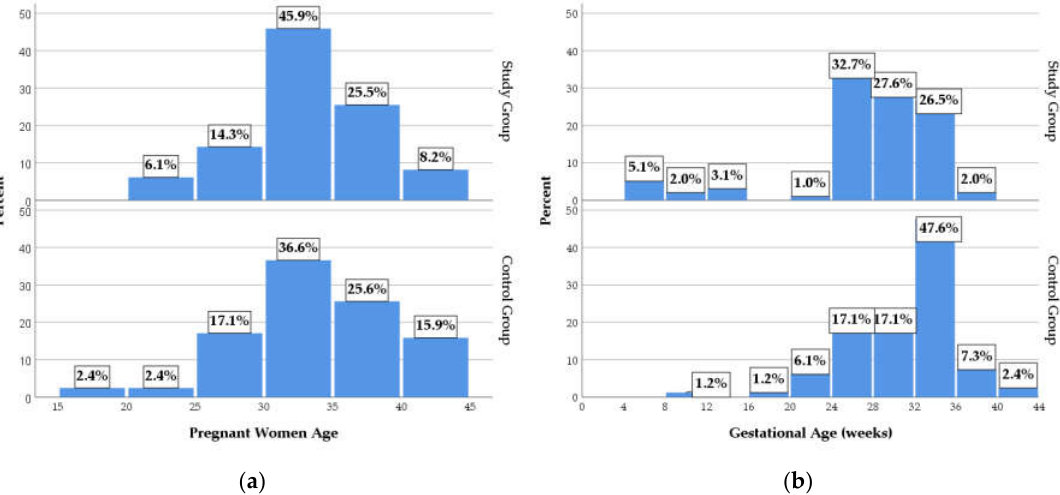
Figure 2. ( a ) Distribution according to the age of the PWs; ( b ) distribution according to gestational age.